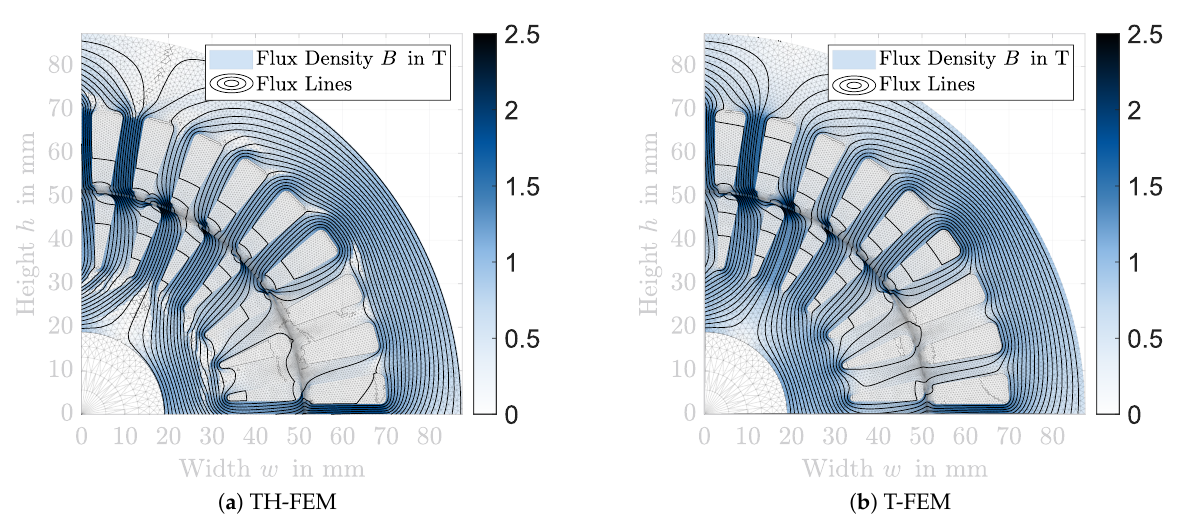
Figure 6. Simulated magnetic flux density and isolines for an exemplary